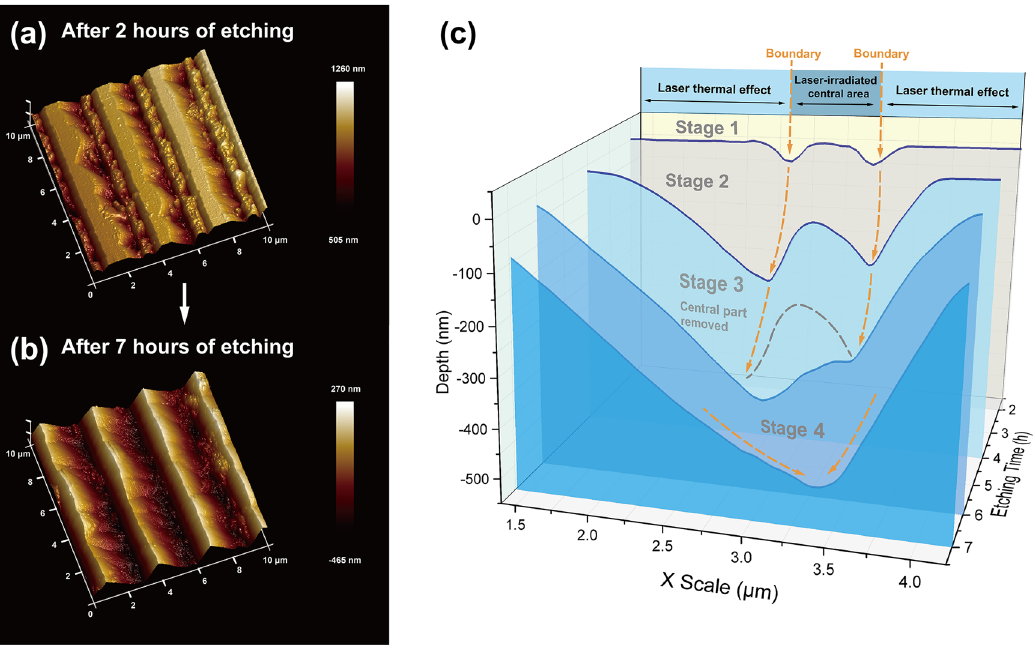
Figure 3: (a) and (b) are the surface morphologies after etching for 2 and 7 h, respectively. (c) shows the evolution of LN surface morphology after 2 h (stage 1), 4 h (stage 2), 6 h (stage 3), and 7 h (stage 4) etching. The gray dotted line in stage 3 indicates the removed laser-irradiated area. 2 µm. Figure 4a shows a scanning electron microscopic (SEM) image of the l = 3 fork grating. The groove structure has a duty cycle of approximately 1:1, which guarantees the diffraction ef fi ciency of the fork grating. The diffraction patterns are measured by using a 750 nm laser as shown in Figure 4b – d, in which the optical vortexes of different l or- ders can be clearly seen. The l order of each vortex beam is examined by using a cylindrical lens [41]. The dark strips in the transformed patterns in Figure 4e – g correspond to the values of l . We fi rst measure the powers of + 1 and − 1 order OAM modes separately. Considering the re fl ection loss, the